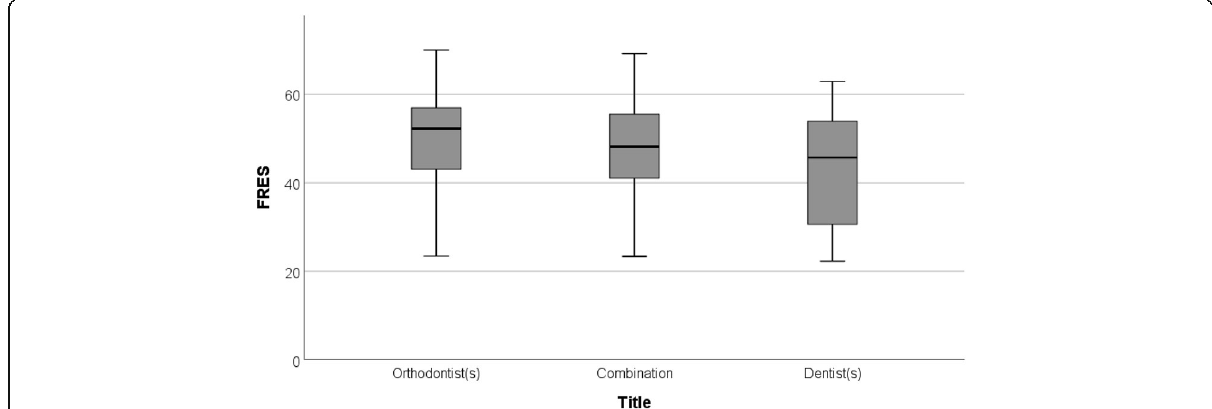
Fig. 2 Box-and-whisker diagram illustrating the distribution of FRES of website information as classified by provider ’ s professional title